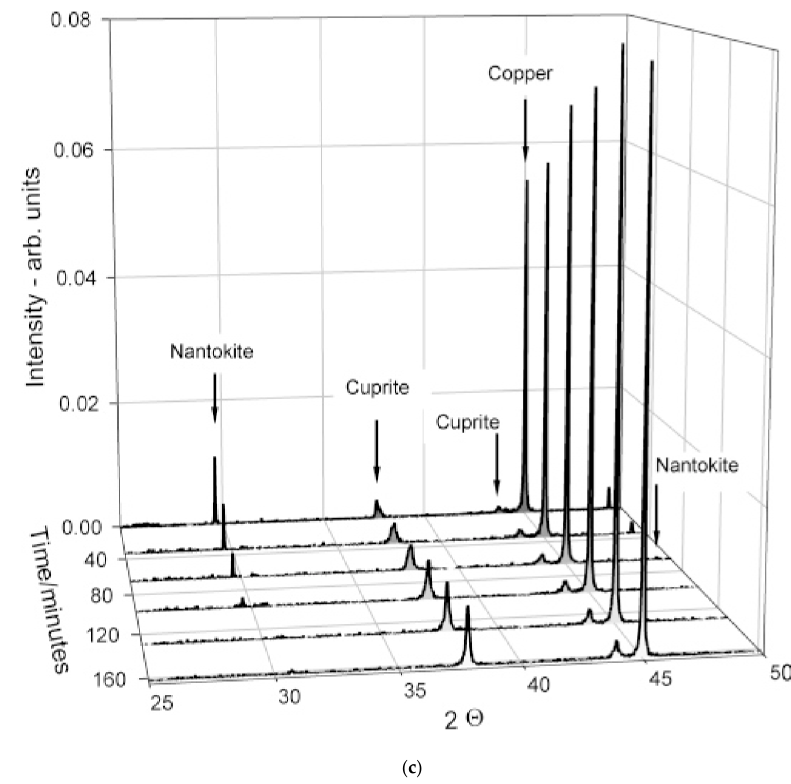
Figure 6. ( a ): Scheme of the experimental setup for a electrochemical impedance measurements combined with a simultaneous X ‐ Ray Diffraction (XRD) analysis of the resulting secondary corrosion metal compounds produced during the deterioration events that occur on metallic coating, present on Cultural Heritage (CH) surfaces; ( b ): Cross ‐ section of the reference electrode. ( c ): The time ‐ resolved spectra typical profiles. Reproduced and reprinted with permission from [15].